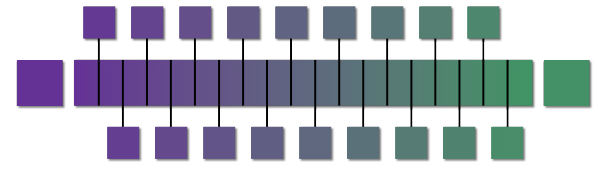
Figure 7: Color ramp generation by interpolation